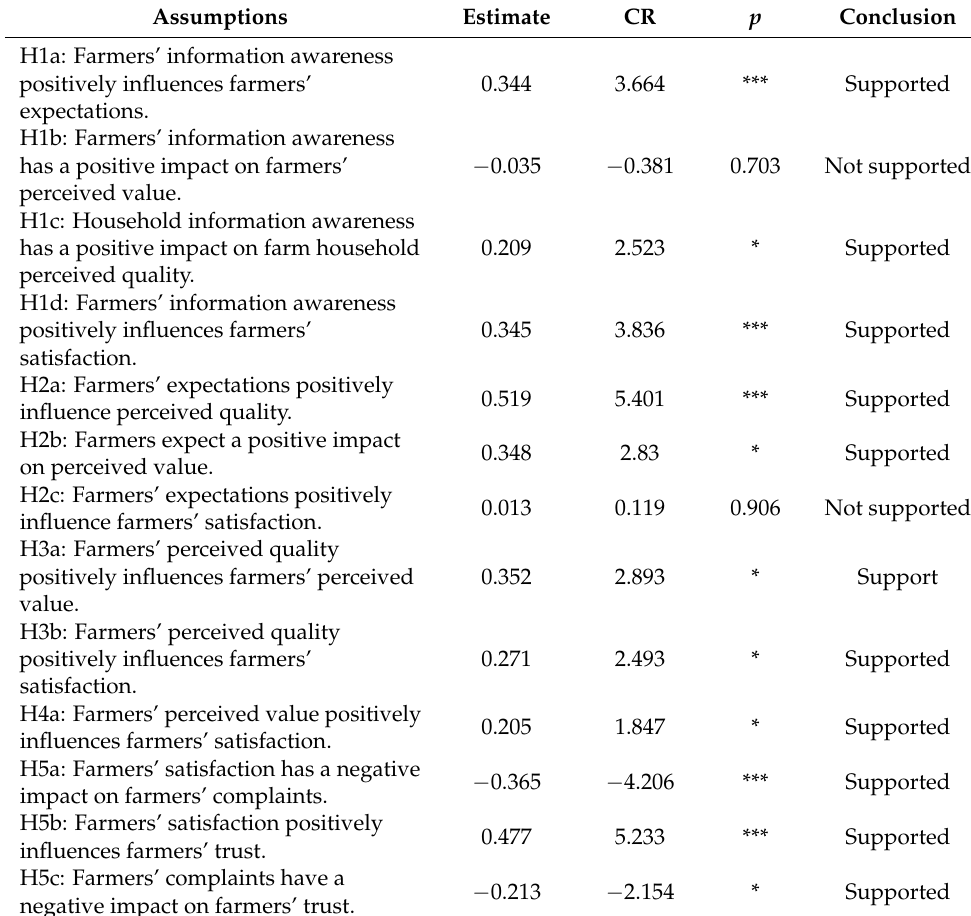
Table 8. Model estimation